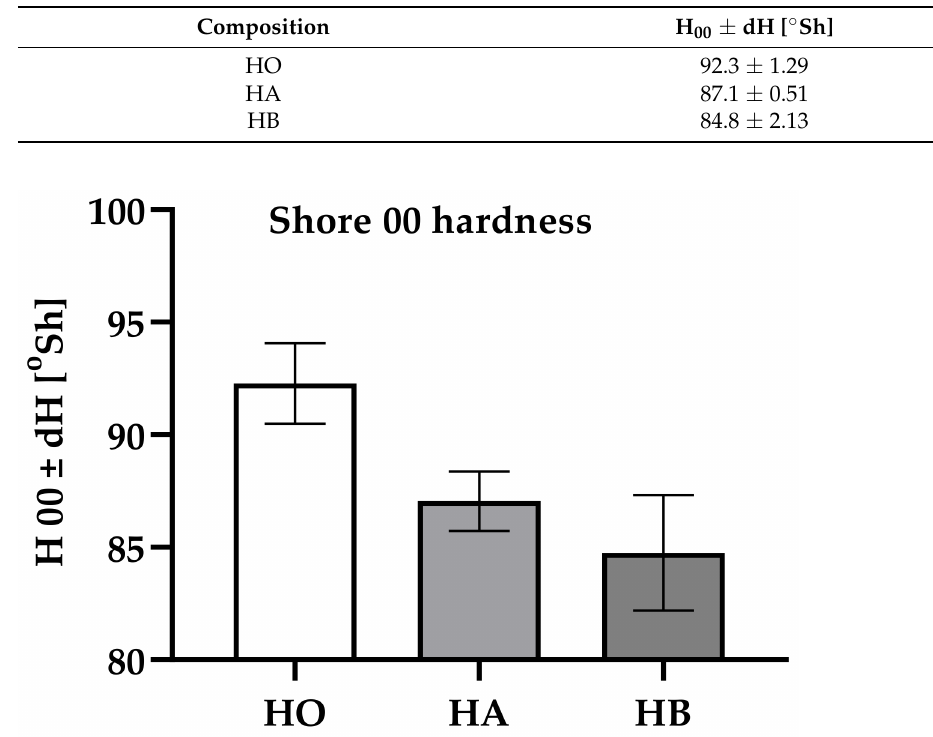
Figure 1. Hardness measurements of the